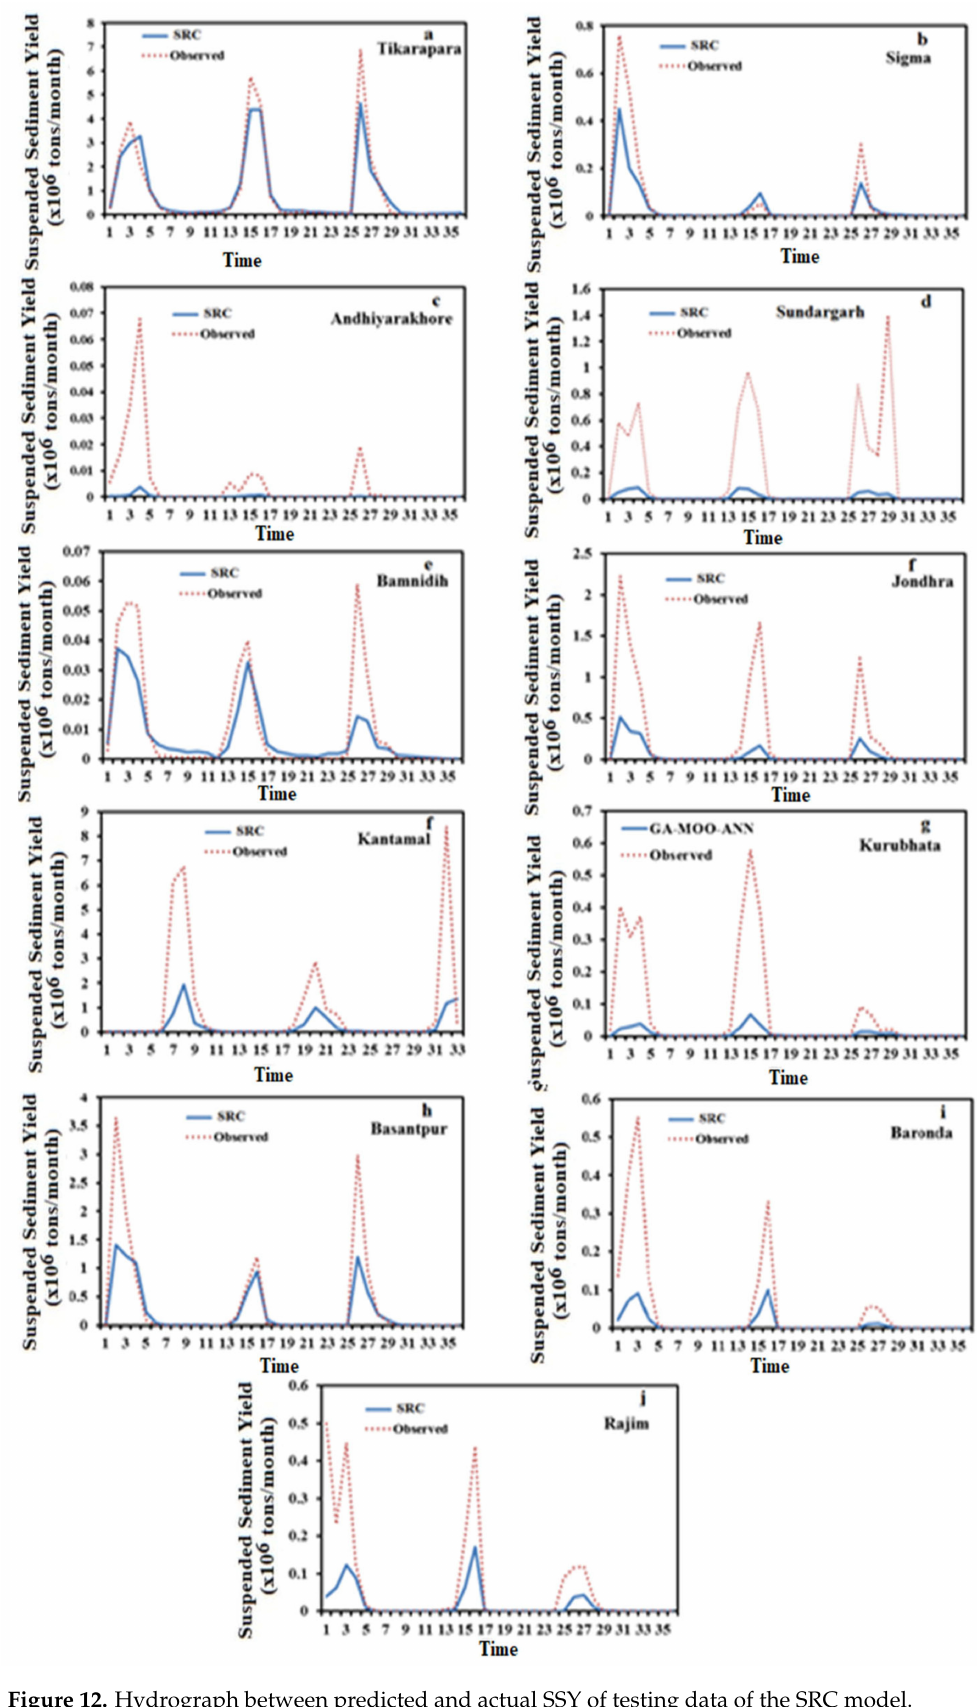
Figure 12. Hydrograph between predicted and actual SSY of testing data of the SRC